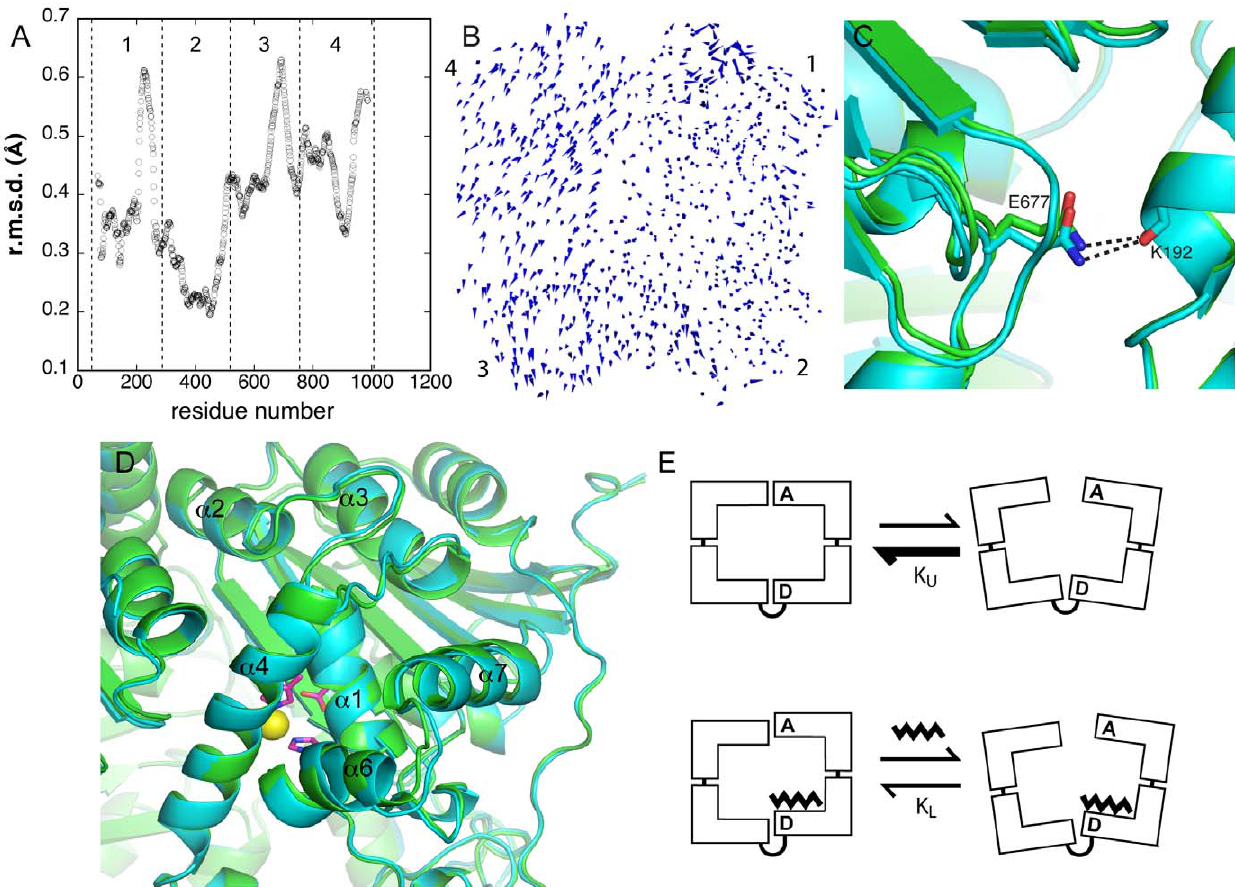
Figure 5. Basis for allosteric activation. (A) Plot of r.m.s. main chain atom positional differences between unliganded IDE and rIDE-E111F with bound peptide ligands at the active and distal sites. Boundaries for domains 1–4 are indicated by the vertical dashed lines. The two structures were superimposed on C a positions in domains 1 and 2. (B) A porcupine type diagram illustrating the conformational change between unliganded IDE and rIDE-E111F superimposed on domains 1 and 2. Cones indicate the direction and magnitude of differences between C a positions. Domains are labeled. The size of the cones has been scaled by a factor of 3 relative to the dimensions of IDE to make the conformational change visible in a small diagram. (C) Example of a change in an interface contact between two halves of IDE comparing aligned unliganded IDE (green) and rIDE-E111F (cyan) structures. (D) Conformational changes in the active site domain (domain 1). Superimposed structures of unliganded IDE (green) and rIDE-E111F (cyan) are shown. Residues at the active site are shown in a stick representation, and the zinc ion cofactor is drawn as a yellow sphere. (E) Model of IDE allosteric activation. In the absence of bound peptide at either the active or distal sites, the equilibrium between the closed and open forms of IDE (K U ) is shifted toward the closed form, which prevents substrate binding and product release. With peptide bound at the distal site (and possibly the active site), the equilibrium (K L ) shifts to increase the population in the open form, enhancing peptide binding and product